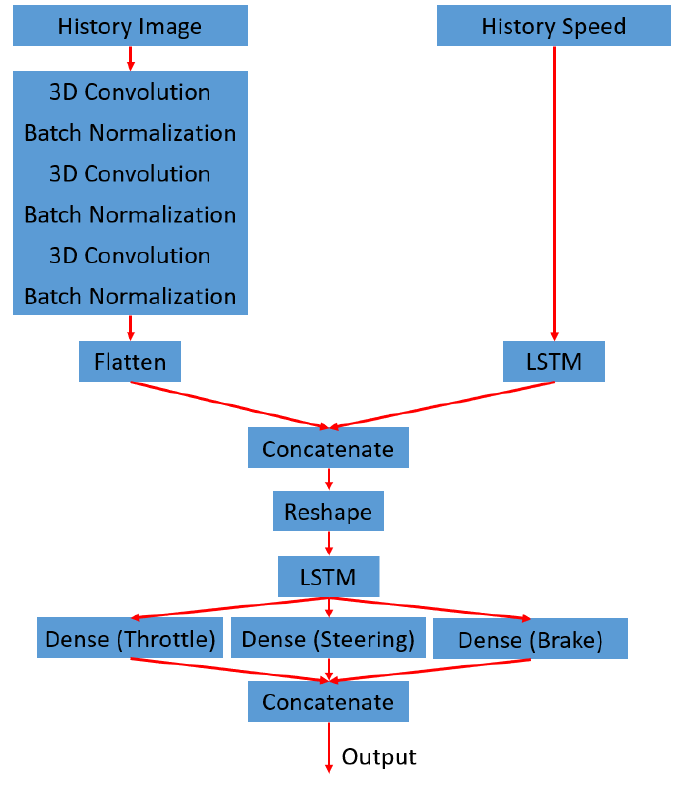
Figure 9. Actor architecture of the RDPG.